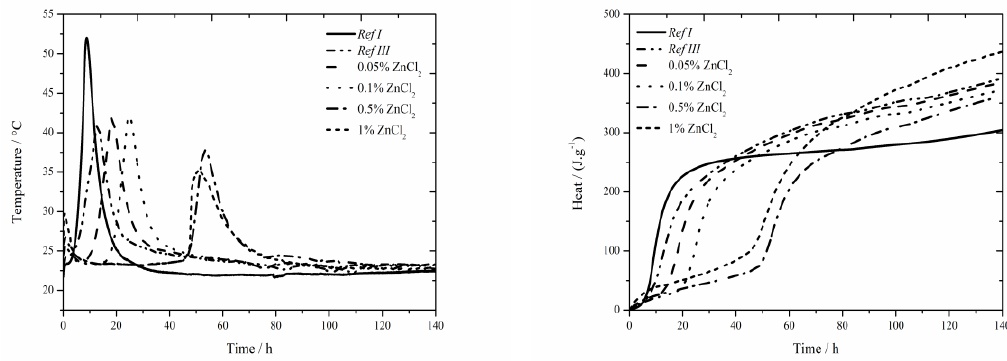
Figure 3. Isoperibolic curves for ZnCl 2 samples.